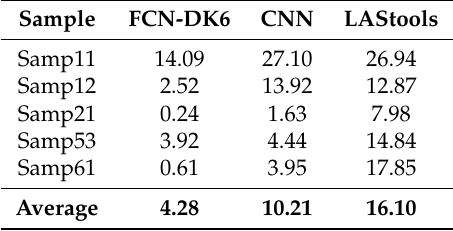
Table 3. Type-I error on ISPRS